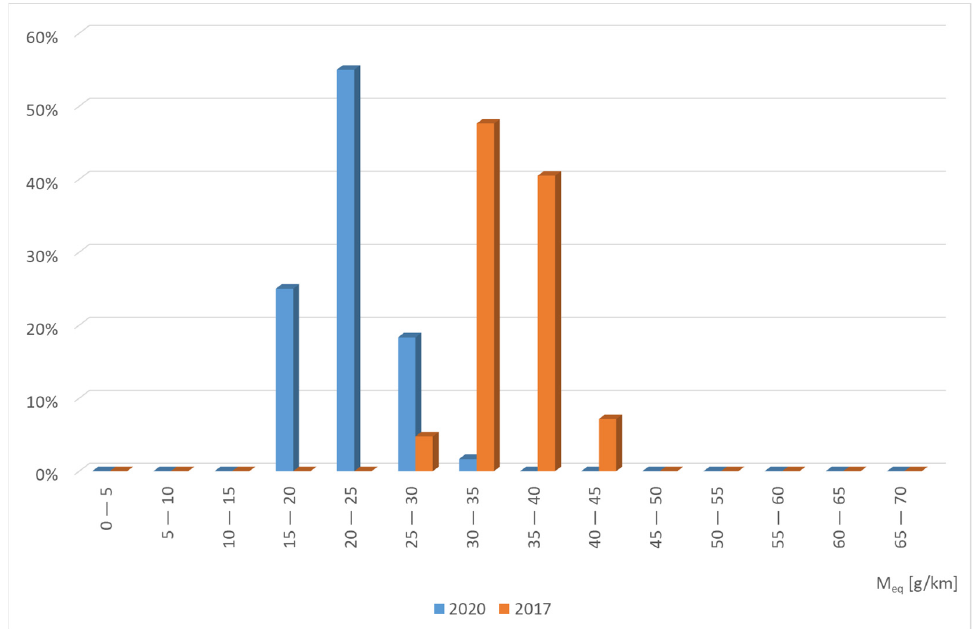
Figure 12. Frequency distribution of the equivalent mileage values.